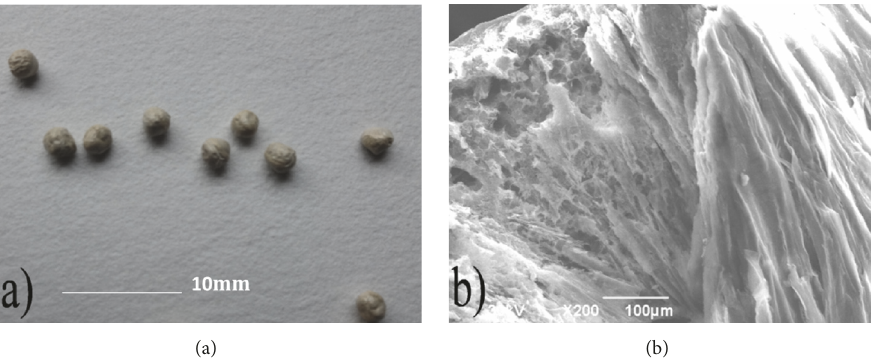
Figure 5: Morphological observations by stereomicroscopy (a) and SEM (b) of the spherical biocarriers prepared from gingko LCC.